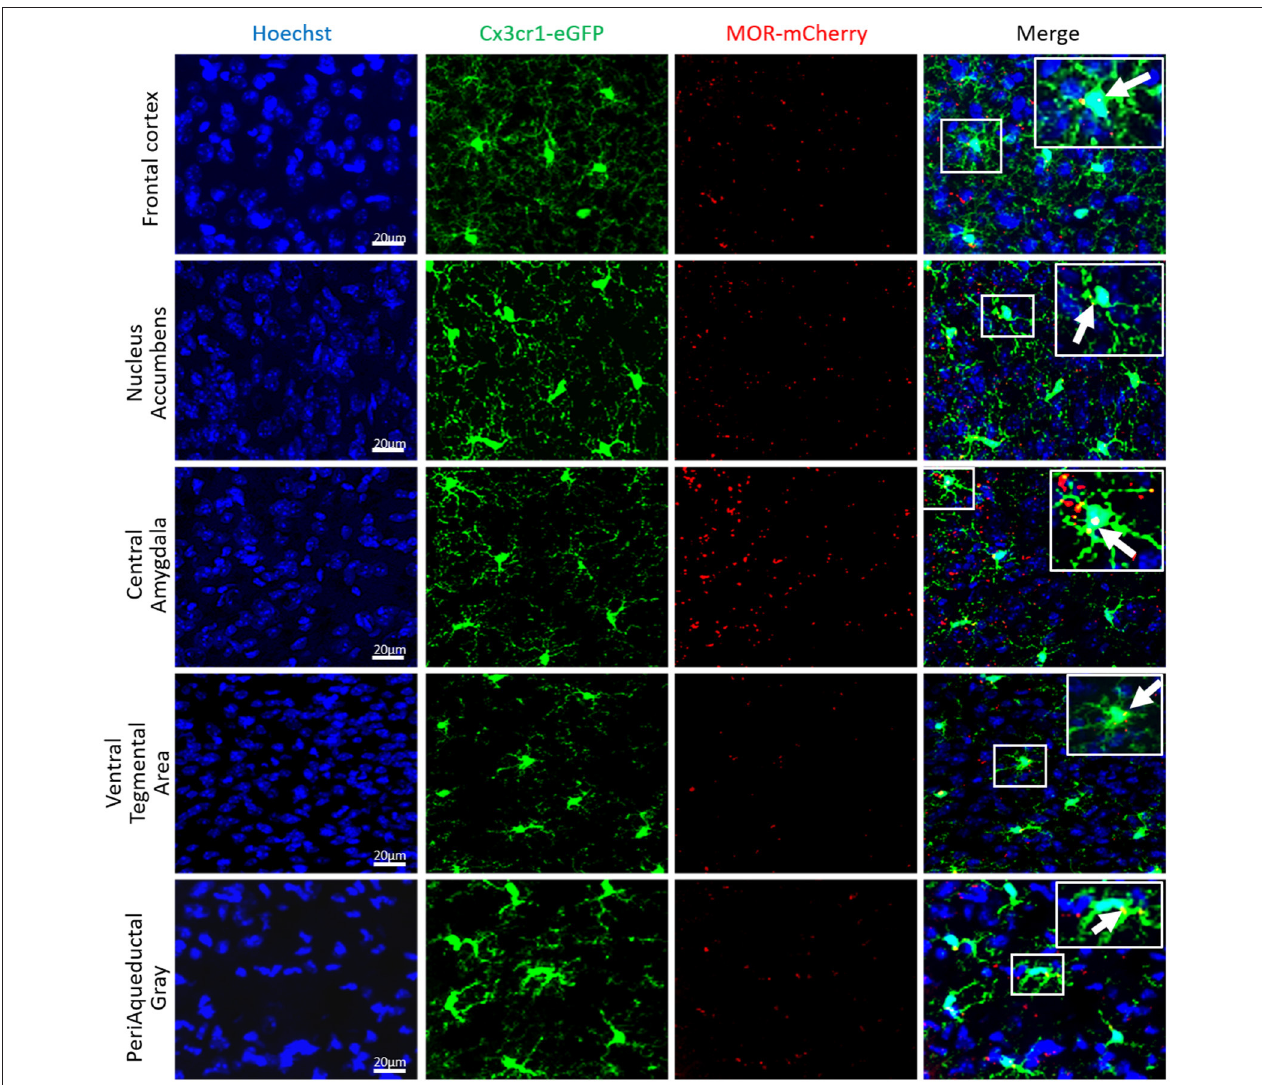
FIGURE 10 | MOR is expressed in mouse brain microglia. Photomicrographs from coronal sections of Frontal cortex (FCx), Nucleus Accumbens (NAcc), Central Amygdala (CeA), Ventral Tegmental Area (VTA), and Periaqueductal Gray (PAG) of Cx3Cr1-eGFP-MOR-mCherry mice show the colocalization (orange) of CX3CR1-eGFP (green), and MOR-mCherry (red) denoted by white arrows. Scale bar = 20 µ m.